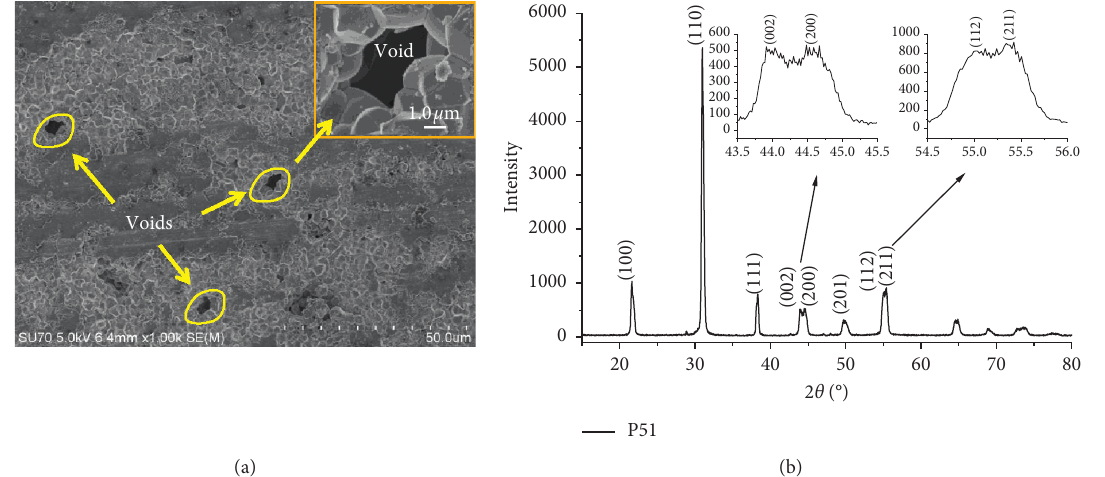
Figure 2: Photograph of (a) SEM and (b) X-ray diffraction pattern of